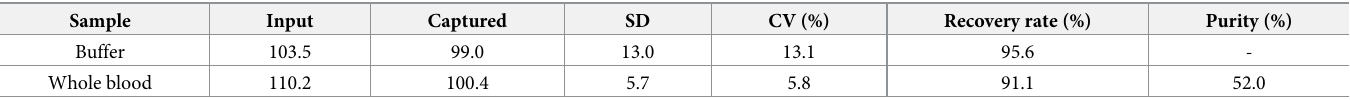
Table 1. Comparison of recovery rate and purity with respect to the sample. Cancer cells were spiked into the whole blood sample to target the injection of 100 cells after which it was mixed ( n = 5; SD is the standard deviation; CV is the coefficient of variation).